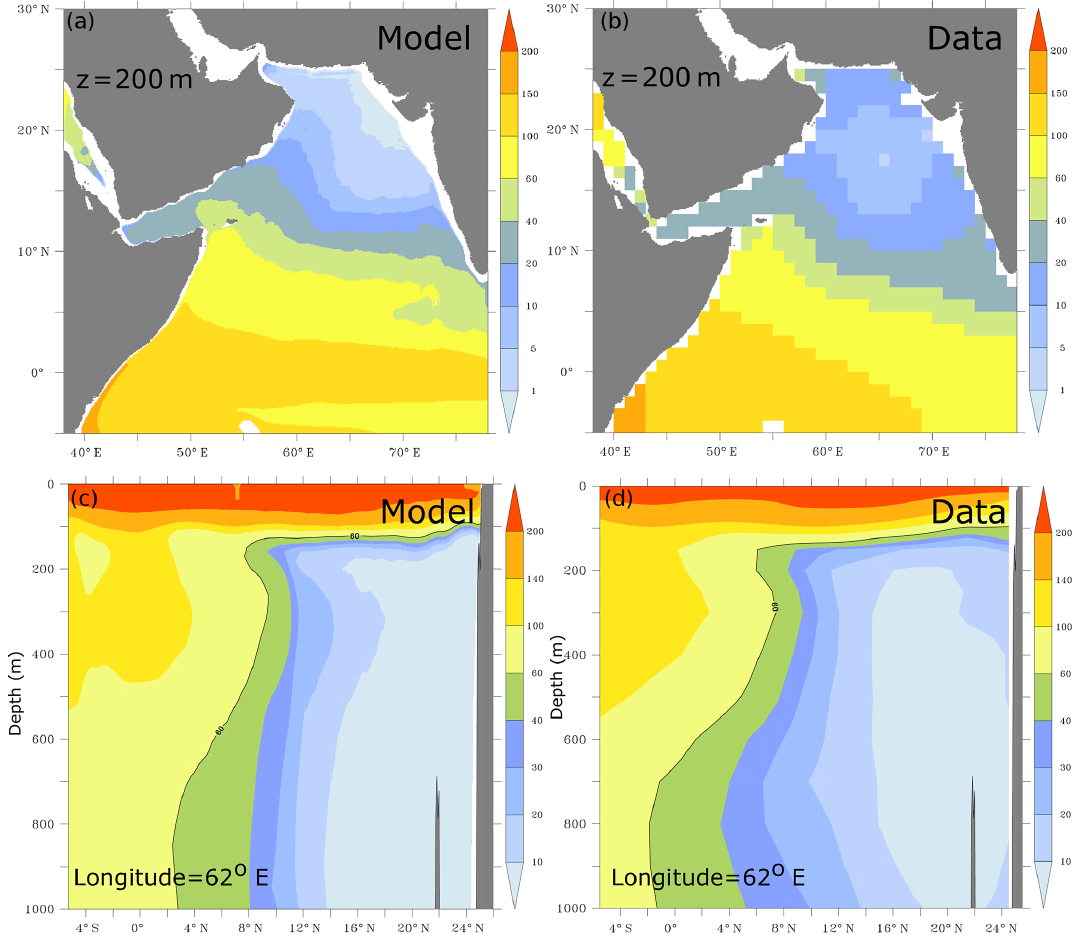
Figure 3. Horizontal and vertical distributions of oxygen. Distribution of annual-mean oxygen (in mmolm − 3 ; a, b ) at 200m and (c, d) in the upper 1000m along 62 ◦ E as simulated in ROMS (a, c) and from the World Ocean Atlas (2009)